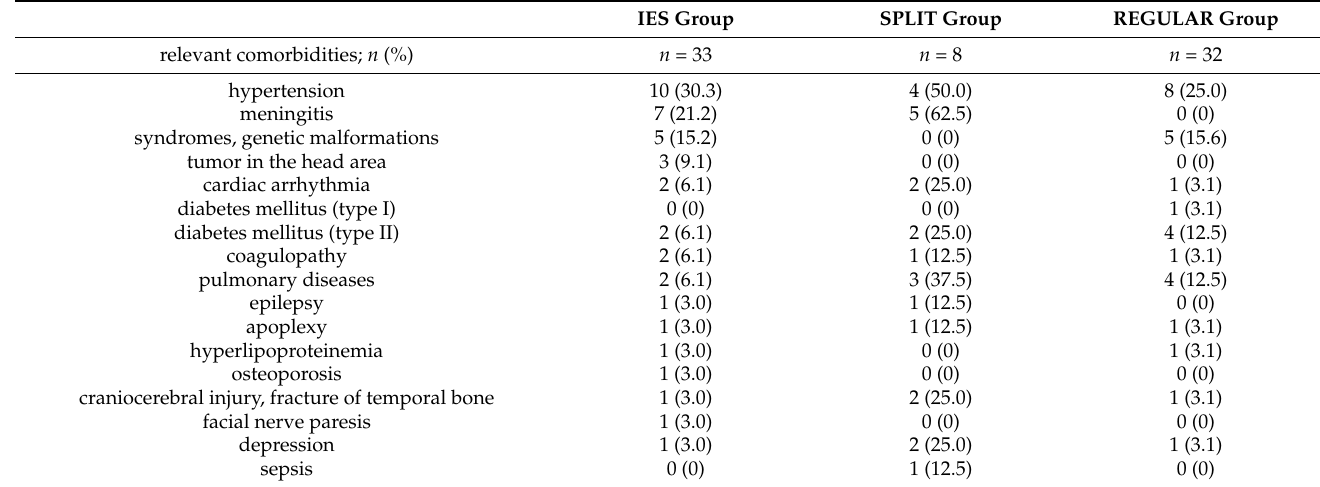
Table 1. A summary of the occurrence of relevant concomitant diseases in subjects of the IES, SPLIT, and REGULAR